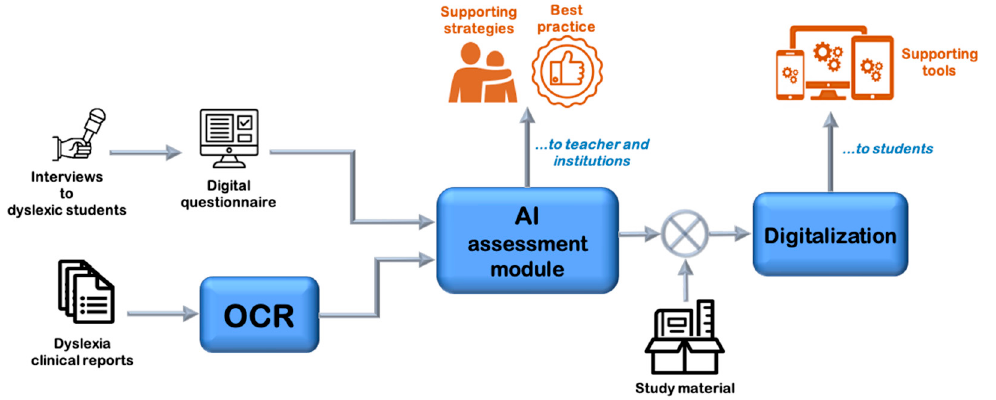
Figure 6. Block diagram of BESPECIAL at its first stage.